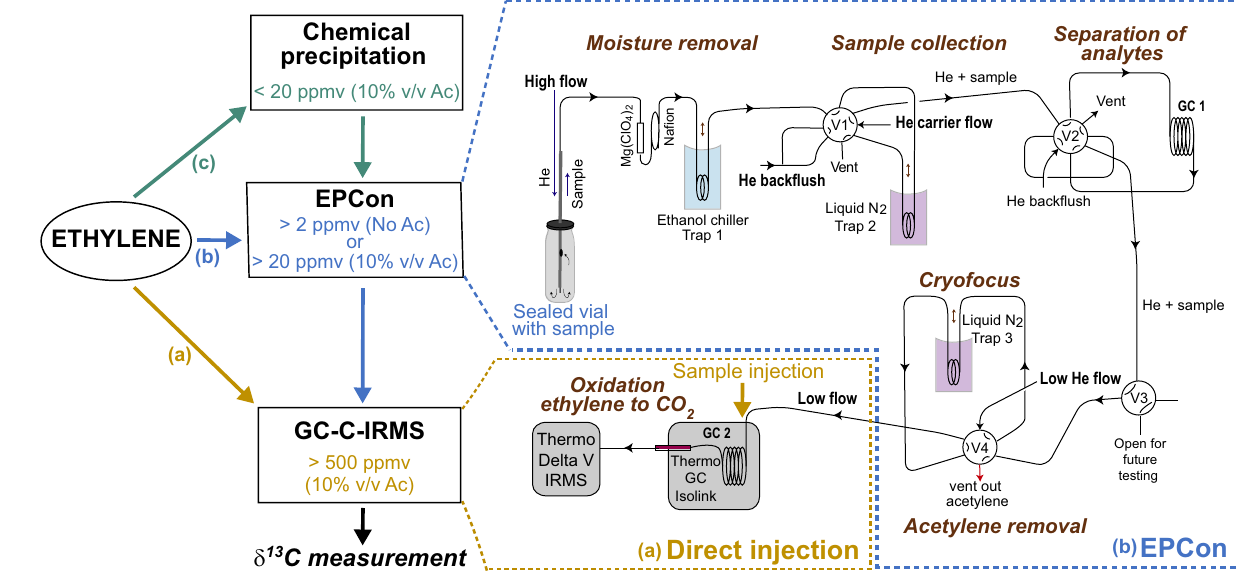
Figure 1. Analytical methodology for δ 13 C measurement of ethylene in a background matrix containing 10% v/v acetylene or no acetylene based on ( a ) classical ISARA methods involving direct injection 12 , ( b ) the EPCon system, which adds ethylene preconcentration and acetylene removal steps, and ( c ) an optional chemical precipitation to remove acetylene 34 prior to sample loading on EPCon. EPCon development and schematic is adapted from Weigand et al. 35 . Abbreviations: Ac –